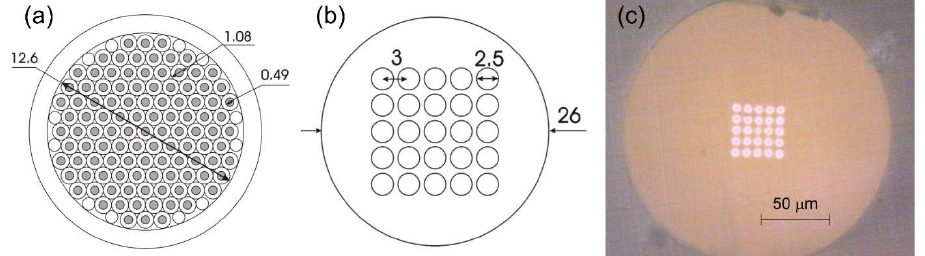
Figure 1. Fabrication of the MCF: ( a ) preform for individual core, ( b ) multicore preform, ( c ) microphotography of the manufactured MCF. Dimensions in ( a , b ) are given in mm.